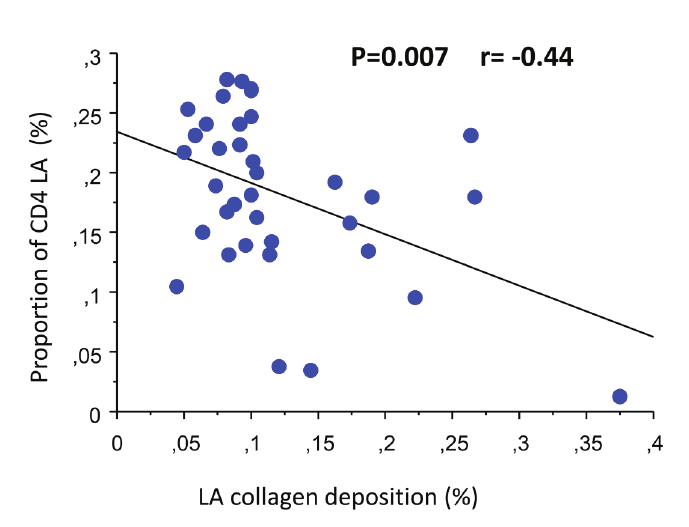
Figure 1. Lymphoid aggregate (LA) fibrosis and CD4+ T lymphocyte frequency. Figure legends: X axis: percentage of lymphoid aggregate collagen deposition (%) Y axis: proportion of CD4 lymphoid aggregate